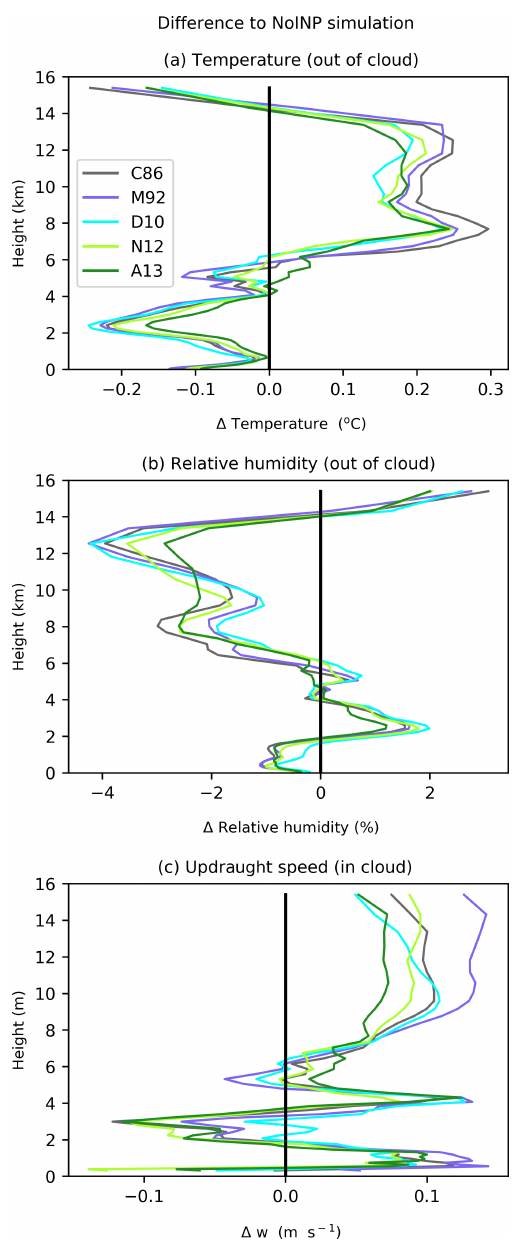
Figure A5. Effect of INPs on domain-mean out-of-cloud temperature (a) and relative humidity (b) as well as in-cloud updraught speed (c) . The difference from the NoINP simulation is shown, with a positive value indicating a higher value when INPs are